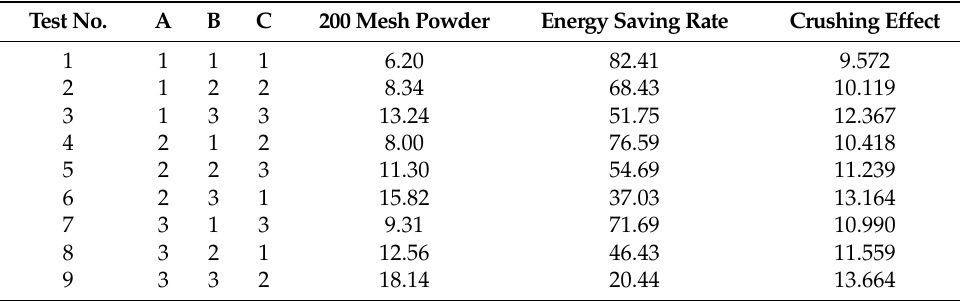
Table 3. Results of the comminution experiment.